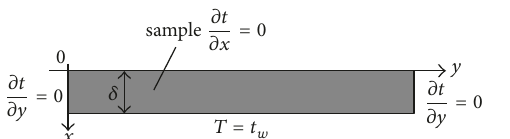
Figure 1: Nonsteady heat transfer model with constant temperature boundary